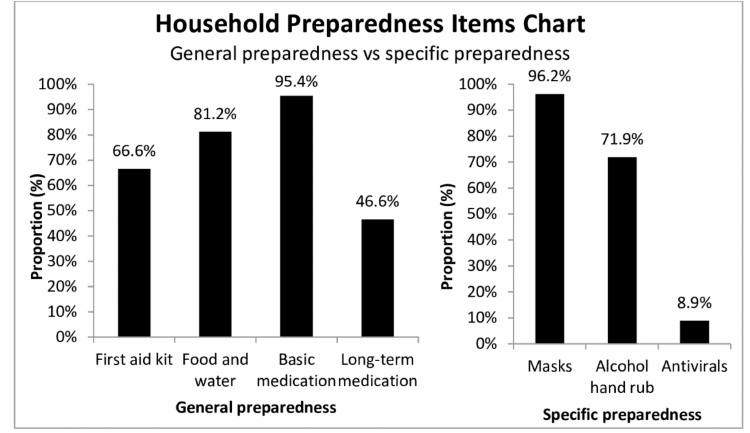
Figure 3. Proportion of respondents with household preparedness items (general and specific).